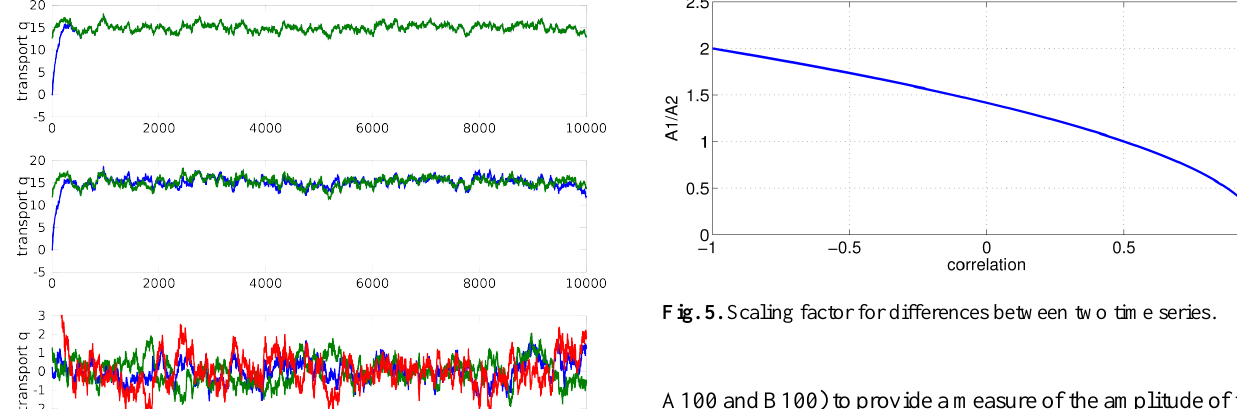
Figure 3: Conceptual box-model used to illustrate how to extract the chaotic MOC component from the NEMO experiments. See main text for explanations.